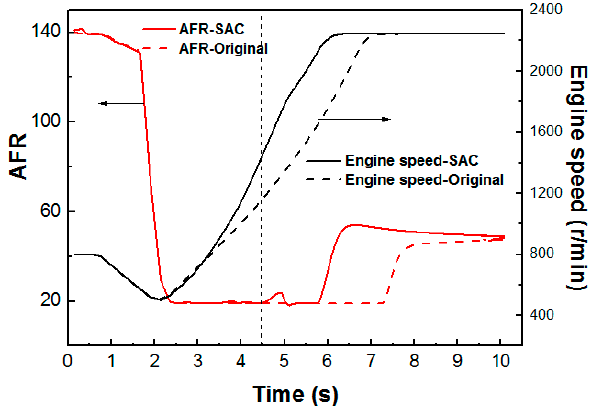
Figure 14. Vehicle starting process simulation results. Engine speed and AFR.